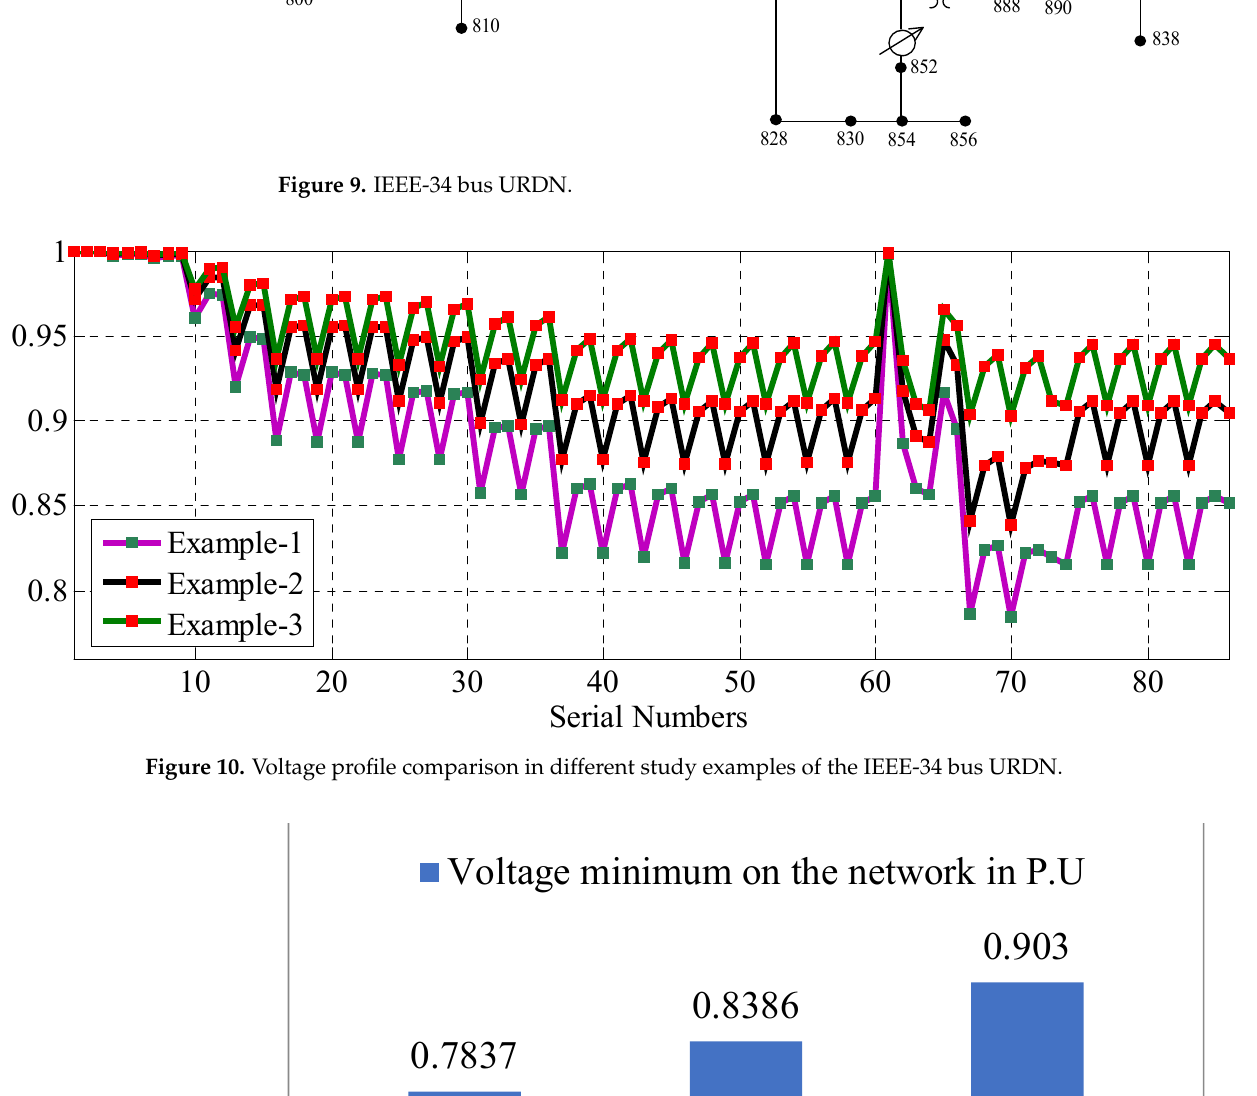
Figure 9. IEEE-34 bus URDN.